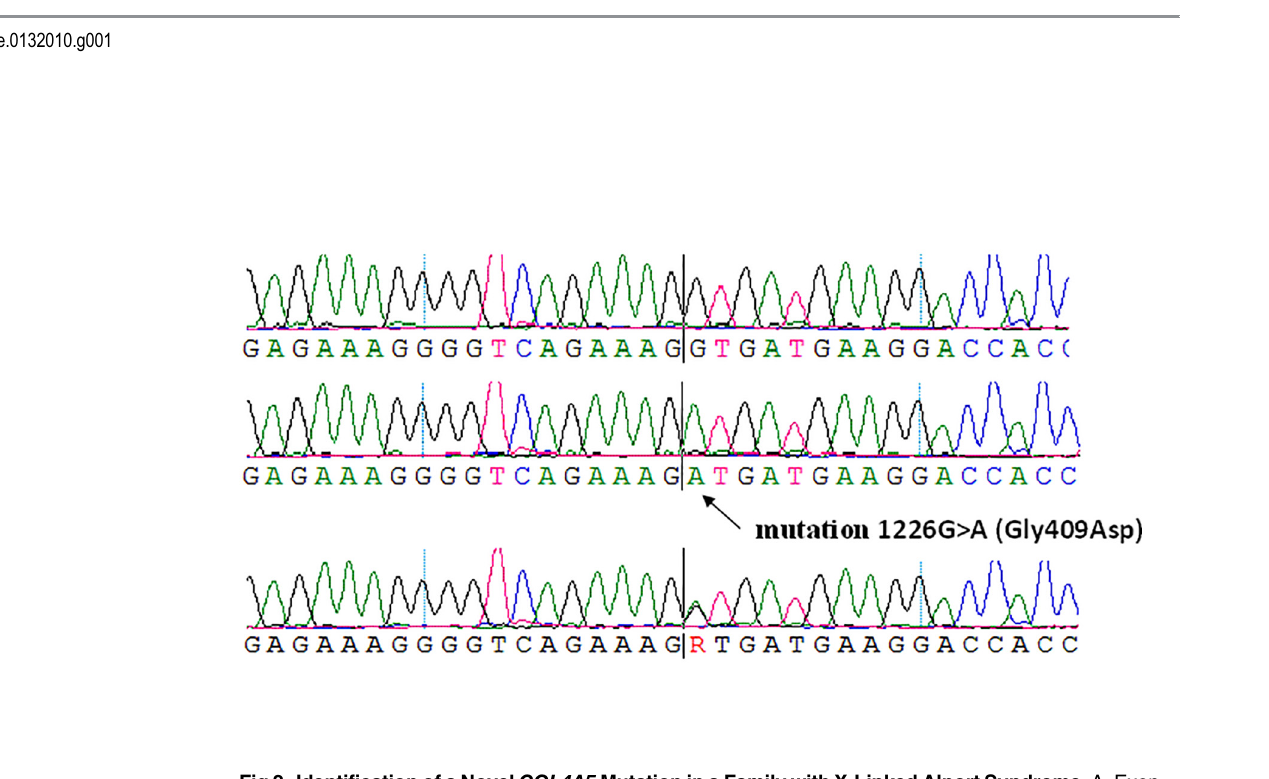
Fig 2. Identification of a Novel COL4A5 Mutation in a Family with X-Linked Alport Syndrome. A. Exon 25 sequencing from a normal male individual. B. Sequencing from a heterozygous female. C. G641E is a mutation that results in 48 abnormal amino acid residues in the COL4A5 protein.